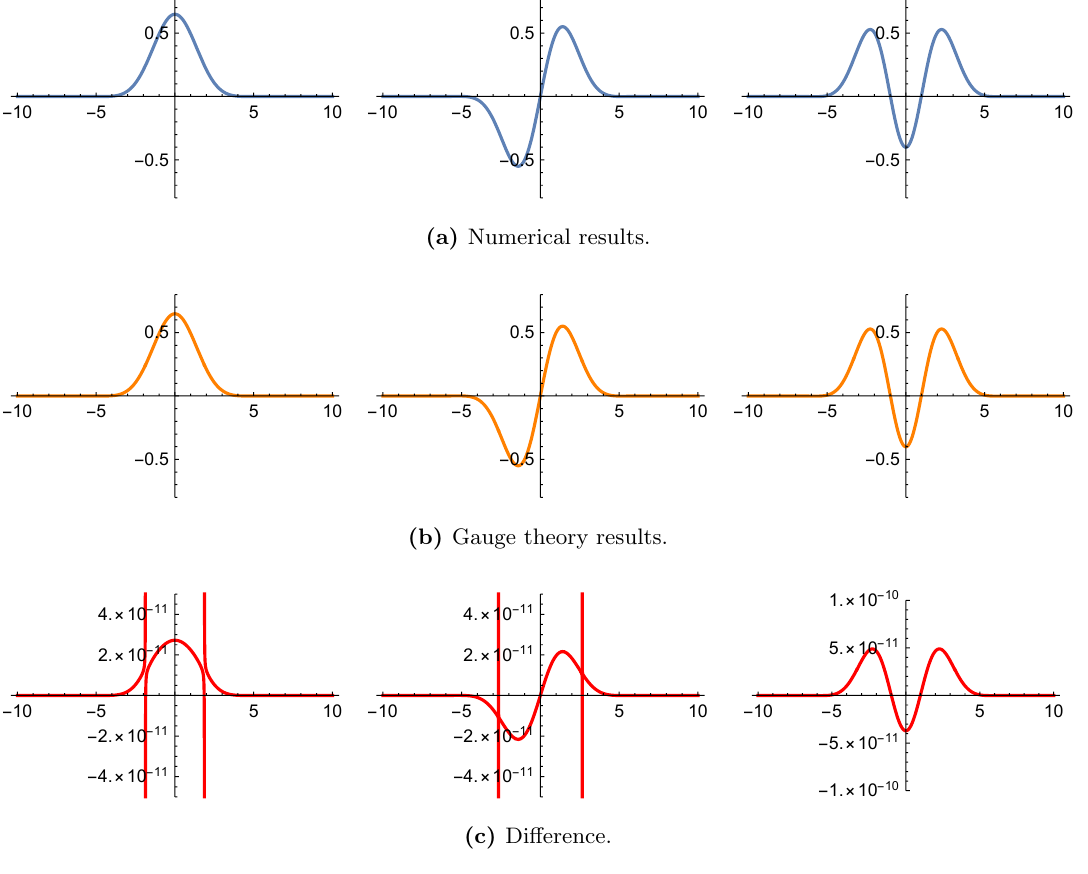
Figure 5. Level n = 0 ; 1 ; 2 Baxter solution q ( (cid:27) ) for Q = 1, ~ = 1 :